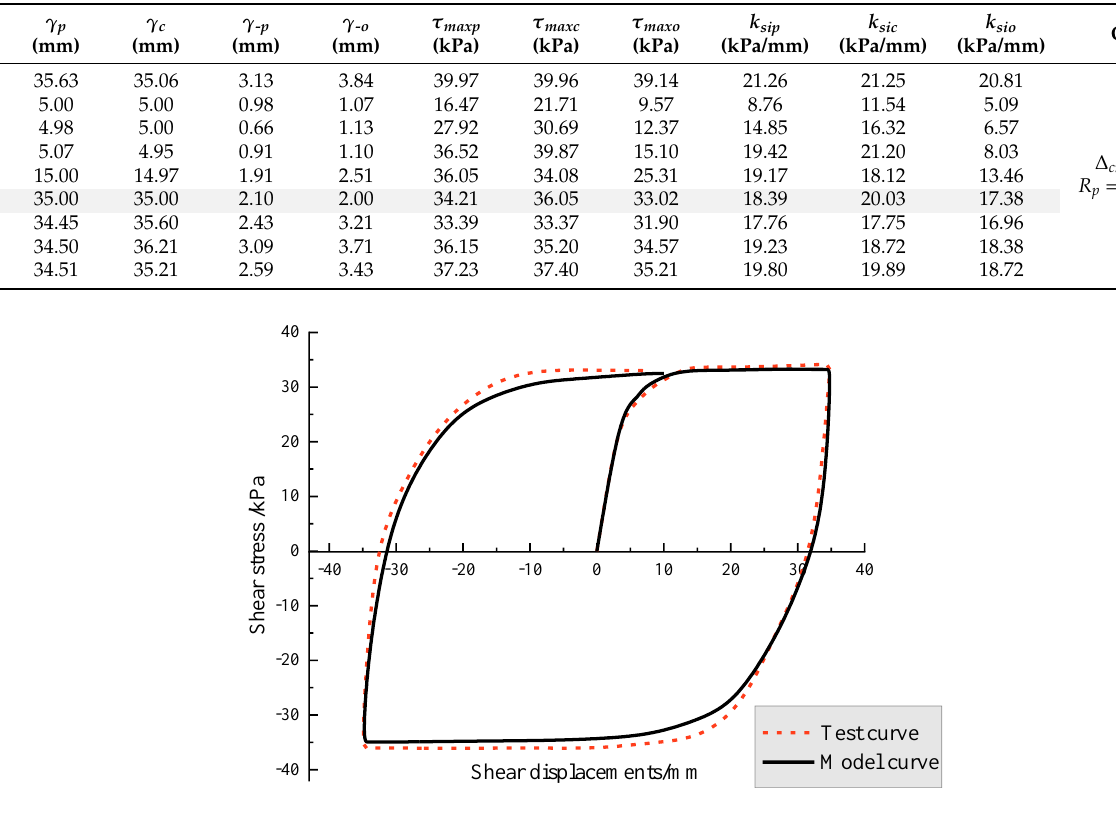
Figure 14. Comparison of theoretical and experimental results.